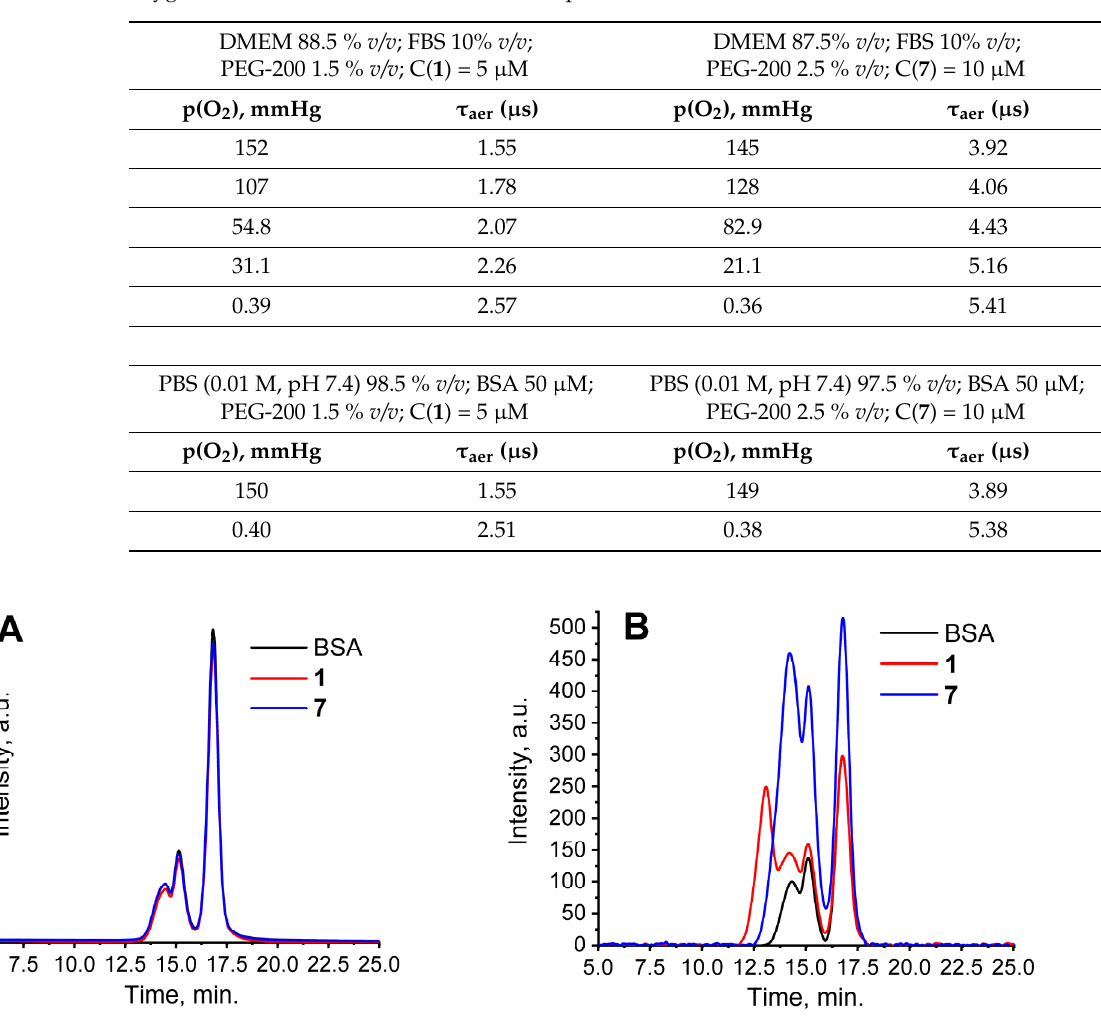
Figure 4. GPC traces of BSA and its mixtures with complexes 1 and 7 recorded with a UV-vis detector at 215 ( A , left) and 380 ( B , right)